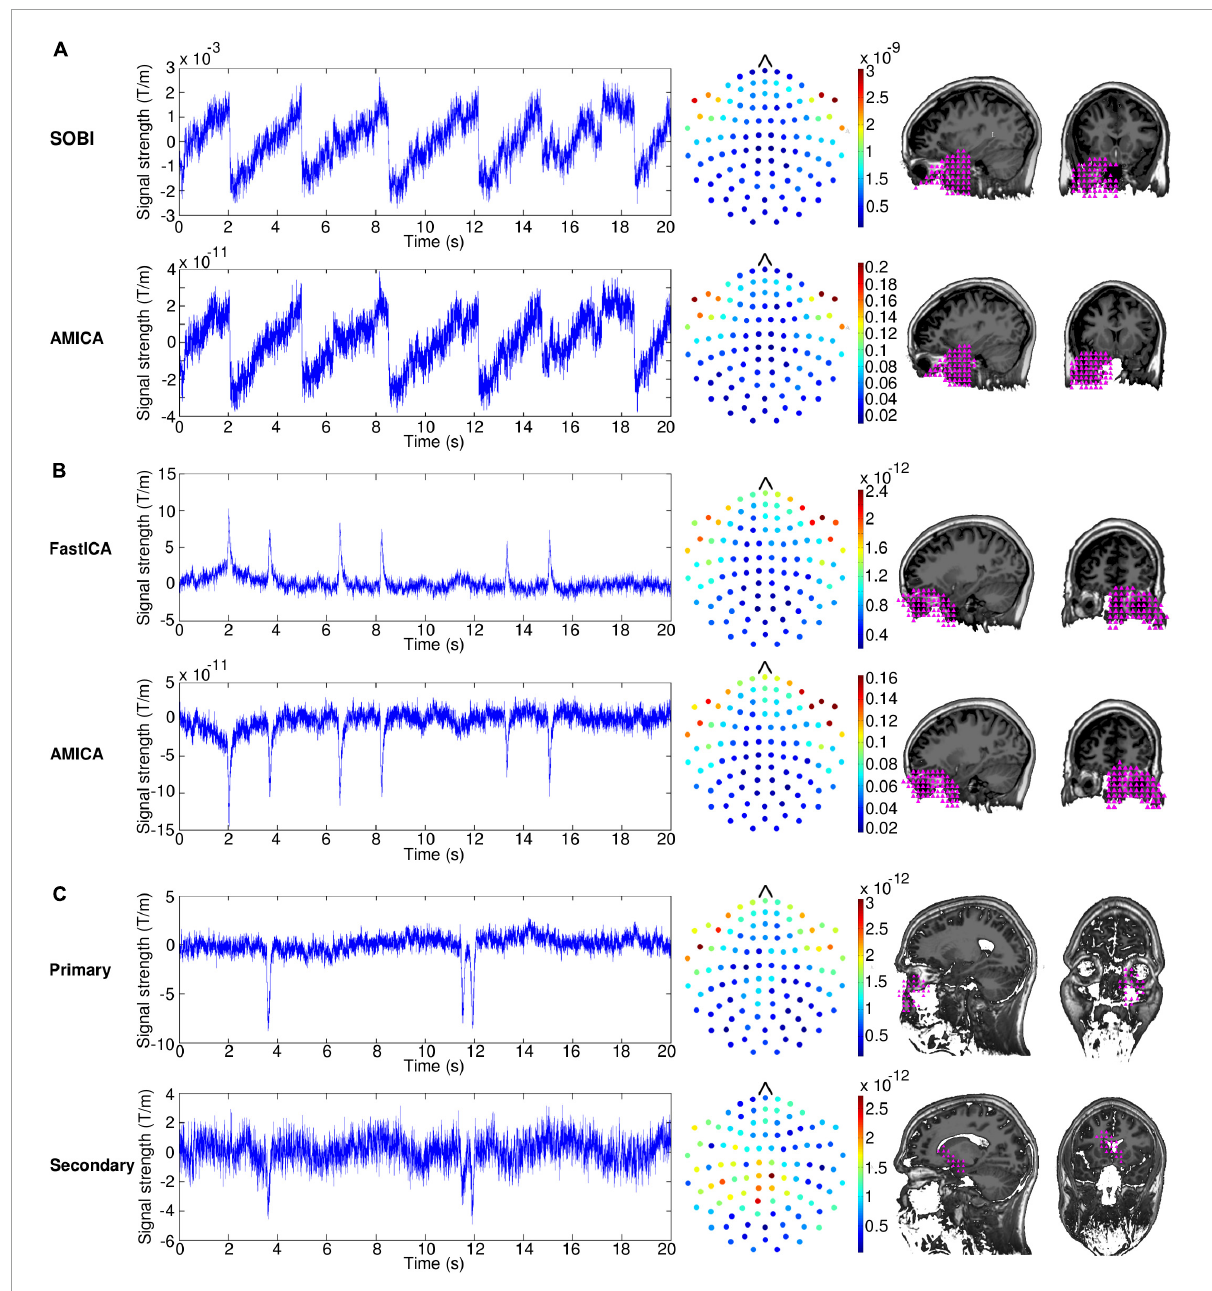
FIGURE1 (A) Time series (left), sensor topographies (middle), and localization results (right) of the saccade component of a single subject for second-order blind identification (SOBI) and adaptive mixture ICA (AMICA). The dots in the sensor topography plots indicate the root mean squares of the mixing matrix weights of the two orthogonal gradiometers at a given location. The localization plots display sagittal and coronal slices at the level of the eye. The pink triangles indicate the locations that are the most probable source areas of the illustrated component. (B) Time series, sensor topographies and localization results of the blink component of a single subject for FastICA and AMICA. (C) Time series, sensor topographies and localization results of the primary and secondary blink component of a single subject extracted with FastICA.